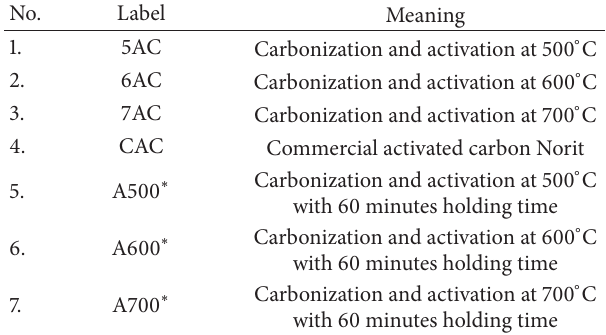
Table 1: List of label for the materials according to the process.